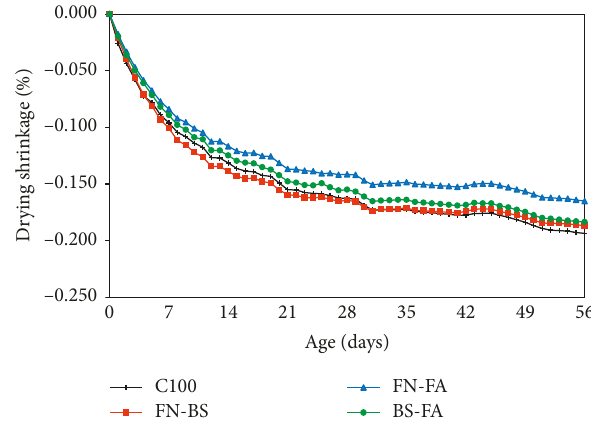
Figure 11: Drying shrinkage of the ternary mortar (Series